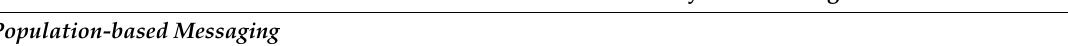
Figure 1. Strengths-based health and wellness promotion through physical activity. Table 1. Reframing weaknesses as strengths in physical activity promotion.